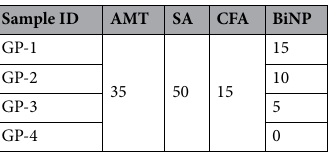
Table 1. Geopolymer mixing design (% weight). AMT mine tailings, SA solid activator, CFA fly ash, BiNP bismuth nanoparticles.